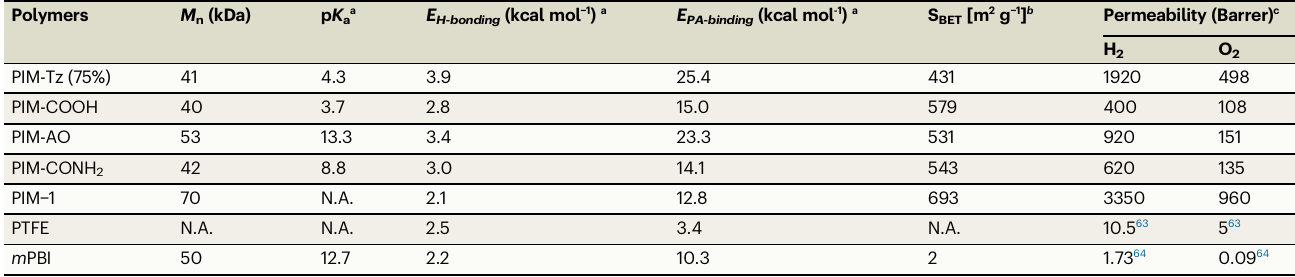
Table 1 | The properties of PIM-1 and its variants. PTFE and m PBI are included for comparison Polymers